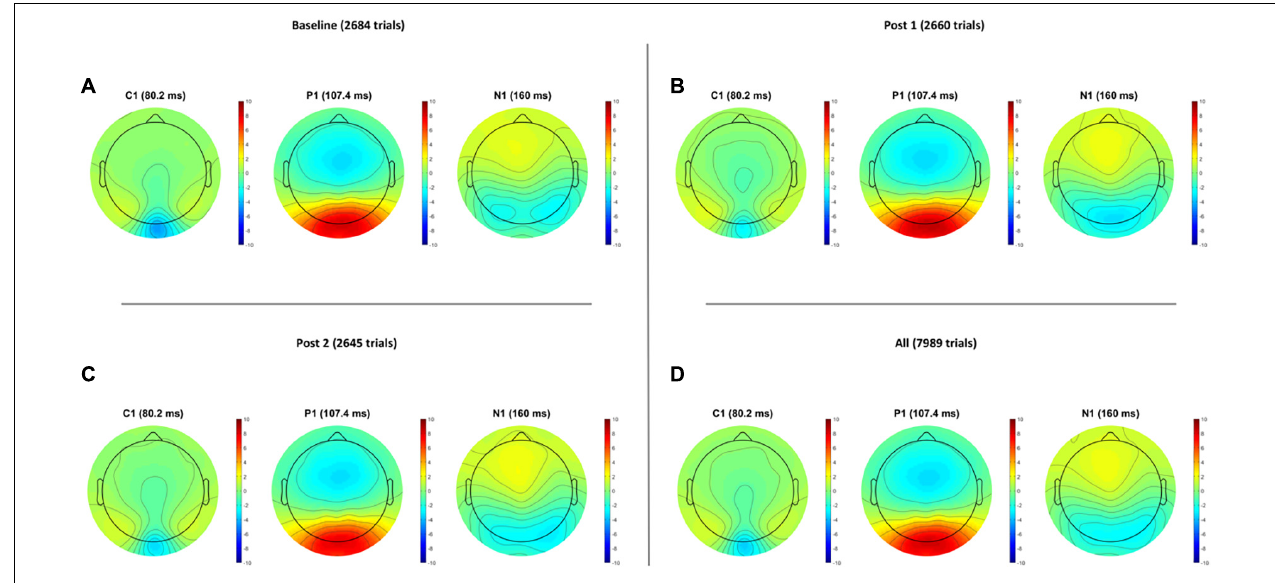
FIGURE 3 | Visual evoked potential amplitude topographies for Baseline (A) , post HFS block 1 (B) , post HFS block 2 (C) , and all post HFS blocks (D) .